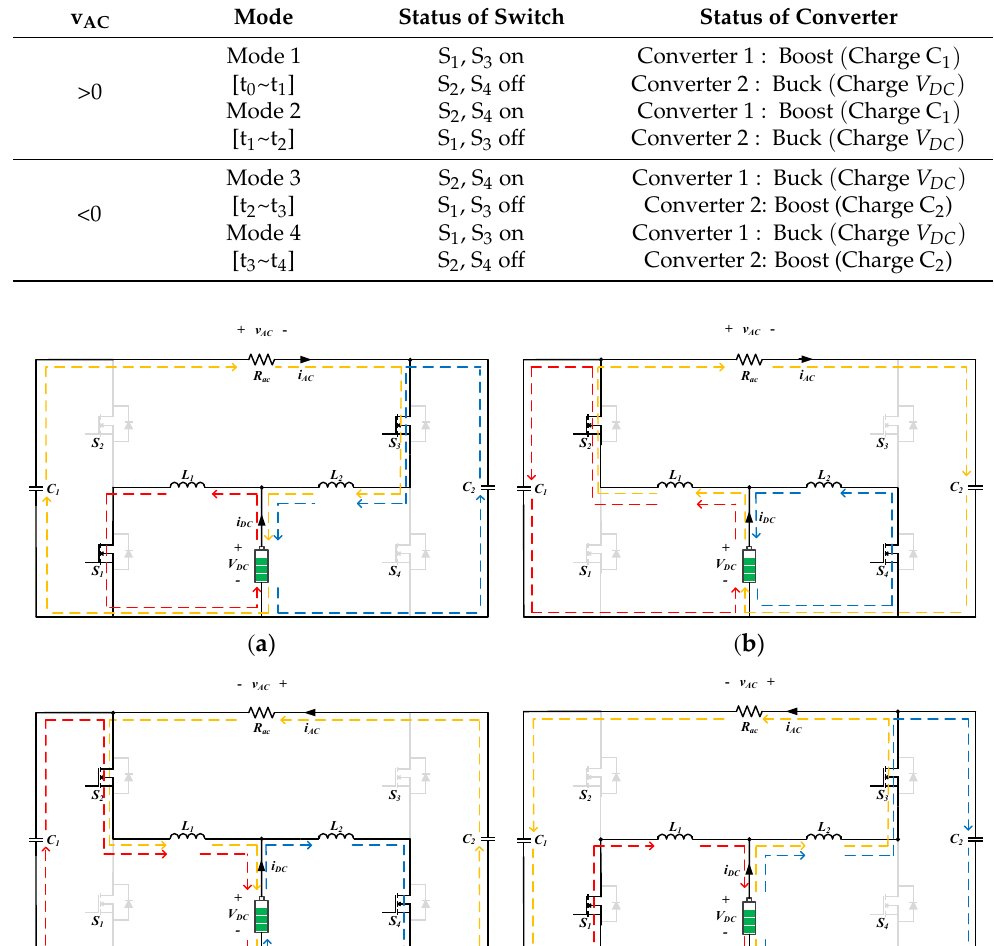
L 2 is −(𝑣 (cid:3004)(cid:2870) − 𝑉 (cid:3005)(cid:3004) ) . The current passed by C 1 is −𝑖 (cid:3002)(cid:3004) , and that passed by C 2 is 𝑖 (cid:3013)(cid:2870) + 𝑖 (cid:3002)(cid:3004) . The